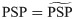
Learning activity ramps on a behavioral timescale with a biologically plausible plasticity window.A-B For orthogonal input patterns (exactly one presynaptic spike arrives at each synapse during 2 s) (A) and a somatic input after 1800 ms (gE = 15 nS during green shading in B and C, gE = 0 otherwise), the learned postsynaptic firing rate has a similar time course as the somatic input if PSP=PSP˜ (B, lines from light gray to black: postsynaptic firing rate after 100, …, 1000 training sessions). C If PSP≠PSP˜ (with τ = 9 ms), the learned postsynaptic firing rate ramps up with an effective time constant of τeff = 600 ms towards the onset of the somatic input. The theoretical result is in good agreement with the simulation (dashed red line: φ(Vw*) computed by Eq 10). During training, the 2 s long pattern of dendritic and the somatic inputs is periodically repeated.